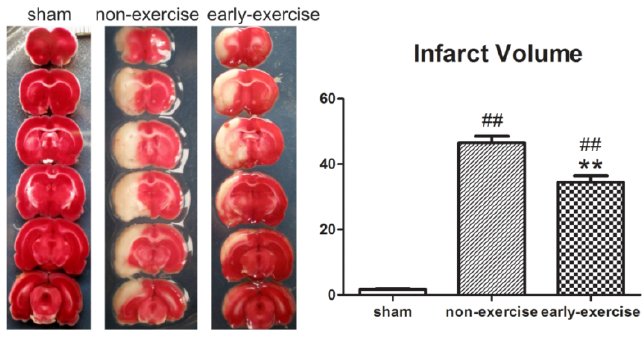
Figure 2. Effect of early exercise on cerebral infarct volume. Compared to non-exercise (NE) rats, early exercise significantly reduced the infarct volume induced by MCAO. ** p < 0.01, compared with the non-exercise group; ## p < 0.01, compared with the sham